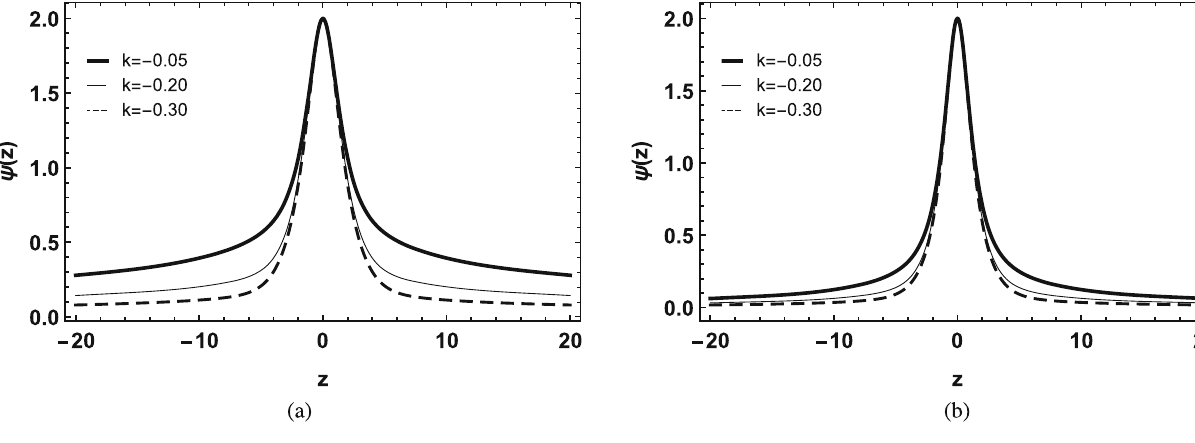
Fig. 5 Behavior of massless modes for G 2 (φ) with n = 2, b = 4 and p = λ = 1. a Gauge field. b KR field The relative probability P ( m ) , for G 1 (φ) , with n =